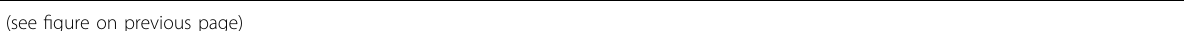
Fig. 4 LINC00263 functions as ceRNA for miR-147a. a , b Cellular fractionation assay was performed to check the localization of LINC00263 . To ensure the purity of the fractions, the levels of α -tubulin (cytosolic marker) and lamin B (nuclear marker) were analyzed by Western blot analysis ( a ). The levels of LINC00263 , 18S , GAPDH , and ACTB mRNA in each fraction were determined by RT-qPCR analysis ( b ). c To check whether LINC00263 is involved in miRISC, Ago2 RNP-IP was performed using a speci fi c antibody. The level of LINC00263 in control IgG and Ago2 IP materials was determined by RT-qPCR analysis and normalized to the level of GAPDH mRNA. d – f To screen for LINC00263 -associated miRNAs, antisense oligonucleotide pull-down (ASO PD) was performed. A schematic of the experimental design is shown ( d ). Detailed information of the ASO sequences for LacZ (control) and LINC00263 was provided in Supplementary Fig. 4a. The ef fi ciency of ASO PD was examined by comparing the level of LINC00263 in ASO PD materials ( e ). Small RNA sequencing was performed with RNAs isolated from ASO PD materials. miRNAs with higher expression in LINC00263 ASO PD are listed ( f and Supplementary fi g. 4b). g Quanti fi cation of copy numbers of LINC00263 and miR-147a (copy number per cell) was performed by RT-qPCR and ddPCR analyses. h – k HeLa cells were transfected with pre-miR-147a (for overexpression, h and j ) or anti-miR-147a (for inhibition, i and k ). Direct association of LINC00263 with miR-147a-involved miRISC was analyzed by Ago2 RNP-IP ( h , i ) and the level of LINC00263 was determined by RT-qPCR analysis ( j , k ). l Following the knockdown of hnRNPK and LINC00263 , the level of miR-147a was determined by RT-qPCR analysis. m Bioinformatic analyses revealed that two MREs of miR-147a exist in the LINC00263 sequence (Supplementary Fig. 7a, b). To examine the sequence-speci fi c interaction, luciferase reporter vectors containing wild-type or mutant sequences of miR-147a MREs were constructed. Following overexpression of miR-147a, the luciferase activity was assessed as described in “ Materials and methods ” . n – s To investigate the effect of miR-147a on malignant capabilities, pre-miR-147a ( n , p , and r ) or anti-miR-147a ( o , q , and s ) were introduced into HeLa cells. Malignant phenotypes including invasiveness ( n , o ), proliferation rate ( p , q ), and clonogenicity ( r , s ) were examined as described in “ Materials and methods ” . Bars on microscopic images represent 100 μ m. Statistical analyses were performed using the Student ’ s t test using three independent experiments (* p < 0.05). All data represent mean ± standard variation